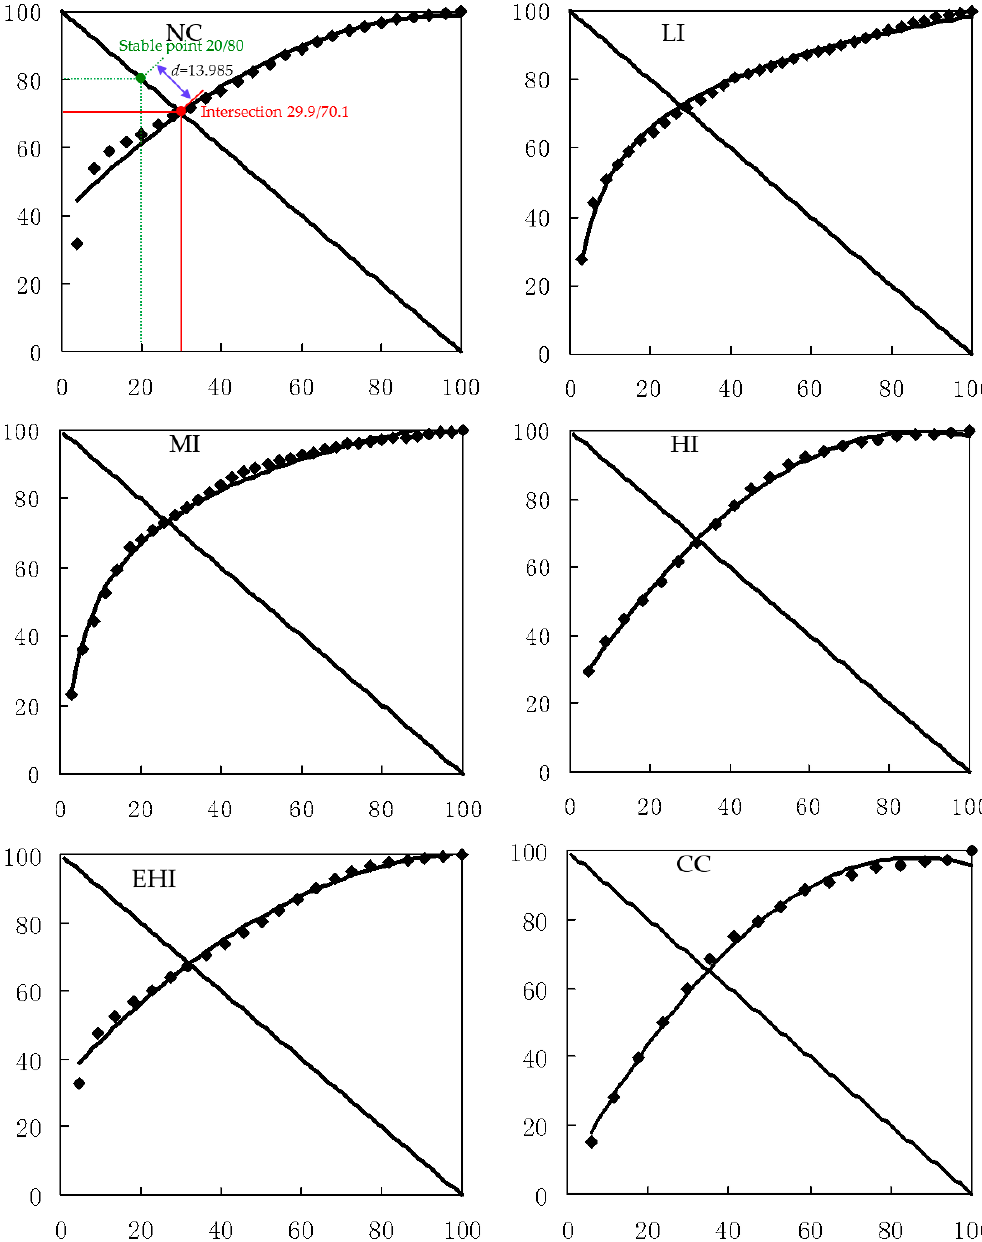
Figure 3. Plant community stability 15 years after different harvesting intensities. Horizontal axis ( x ): Accumulative inverse of species number. Vertical axis ( y ): Accumulative relative frequency. NC indicates non-harvesting; LI indicates selective harvesting at low intensity; MI indicates selective harvesting at medium intensity; HI indicates selective harvesting at high intensity; EHI indicates selective harvesting at extra-high intensity; CC indicates clear-cut harvesting. Table 8. Changes of plant community stability 15 years after different harvesting intensities.